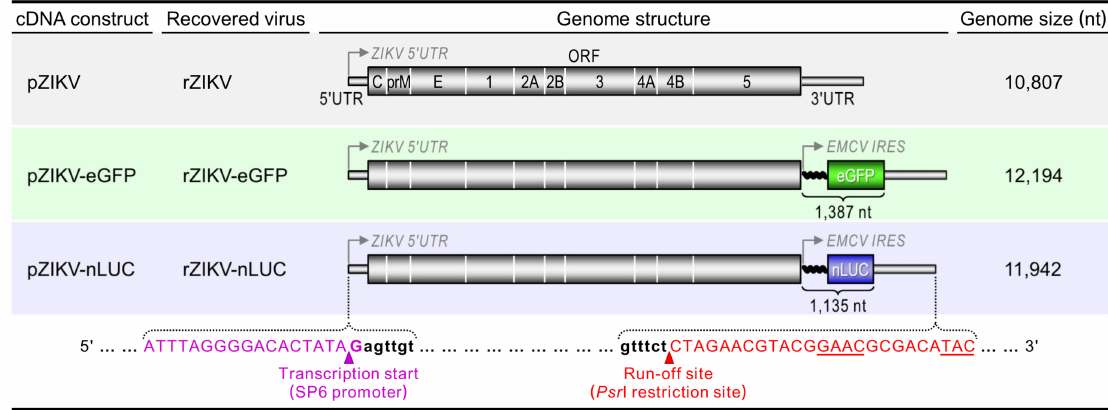
Figure 1. Schematic representation of two reporter-encoding full-length ZIKV cDNA clones. The top panel shows the genome structure of the parental ZIKV (rZIKV) recovered from its full-length cDNA clone (pZIKV). The two bottom panels depict the genome structures of two reporter-encoding ZIKVs (rZIKV-eGFP and rZIKV-nLUC) rescued from their respective full-length cDNA clones (pZIKV-eGFP and pZIKV-nLUC). In both constructs, each reporter gene driven by the encephalomyocarditis virus (EMCV) internal ribosome entry site (IRES) is inserted after the stop codon of the viral open reading frame (ORF) at the beginning of the 3 (cid:48) untranslated region (UTR). The nucleotide sequences provided below the three full-length cDNA clones correspond to the 5 (cid:48) SP6 promoter (magenta uppercase) and 3 (cid:48) unique Psr I restriction site (red uppercase) engineered immediately upstream and downstream of the viral genome (black lowercase), respectively. Also, the arrowheads marked below the nucleotide sequences indicate the transcription start and run-o ff sites for in vitro transcription. The genome size of each recombinant virus is shown, as is the insert size of each reporter gene expression